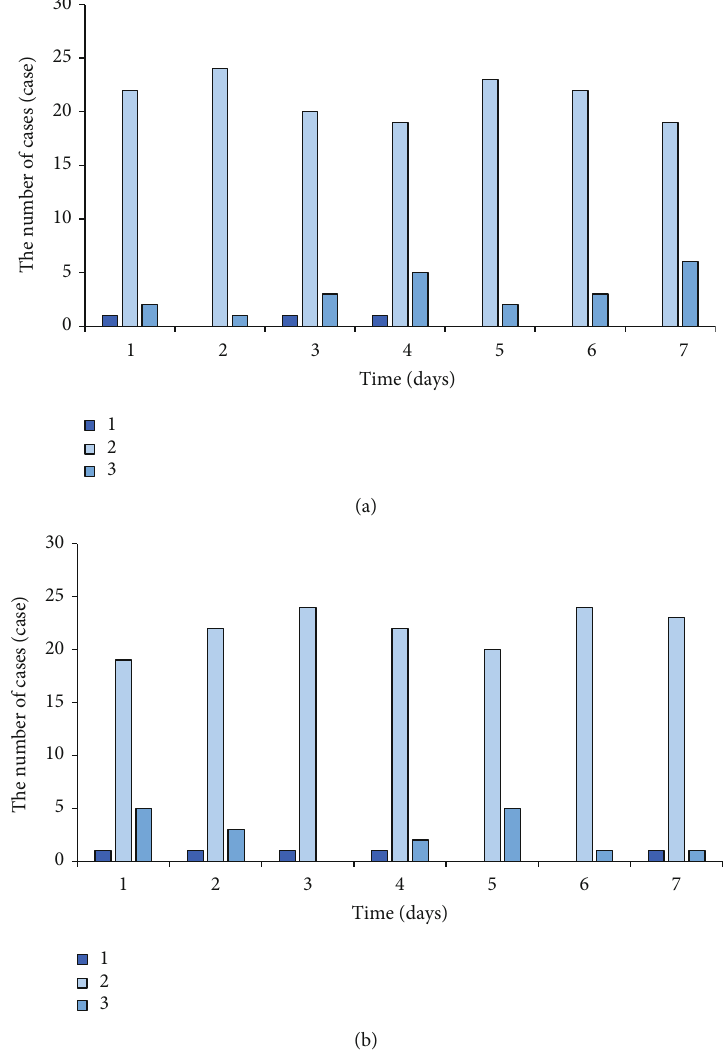
Figure 5: PDU scores of the AKI group and the non-AKI group. (A: AKI group; B: non-AKI